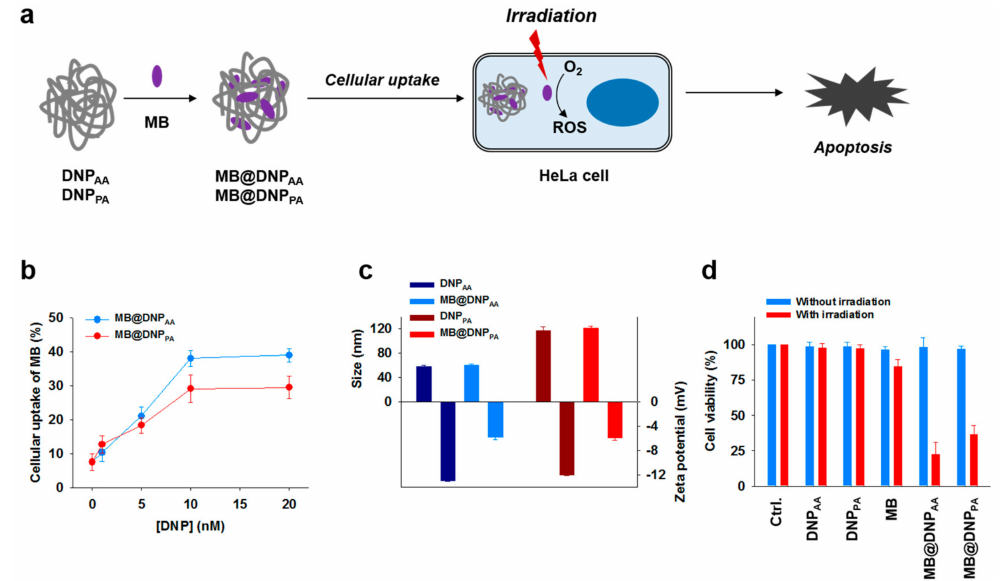
Figure 4. ( a ) Schematic presentation of in vitro photodynamic therapy (PDT) after the intracellular delivery of methylene blue (MB) into HeLa cells using DNP AA and DNP PA as carriers. ( b ) Quantitative analysis of cellular uptake of MB (1 µ M) by DNPs at various concentrations using a flow